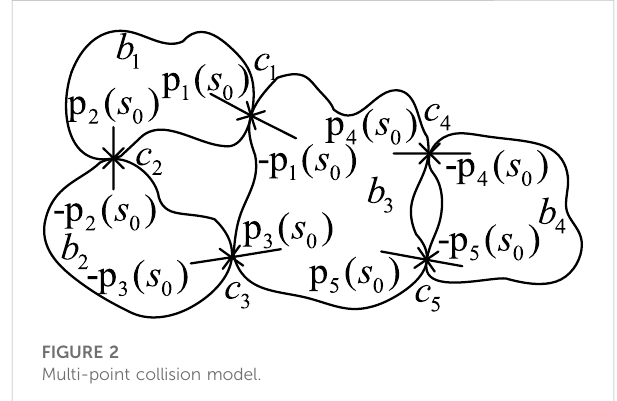
FIGURE 1 Motion mode of